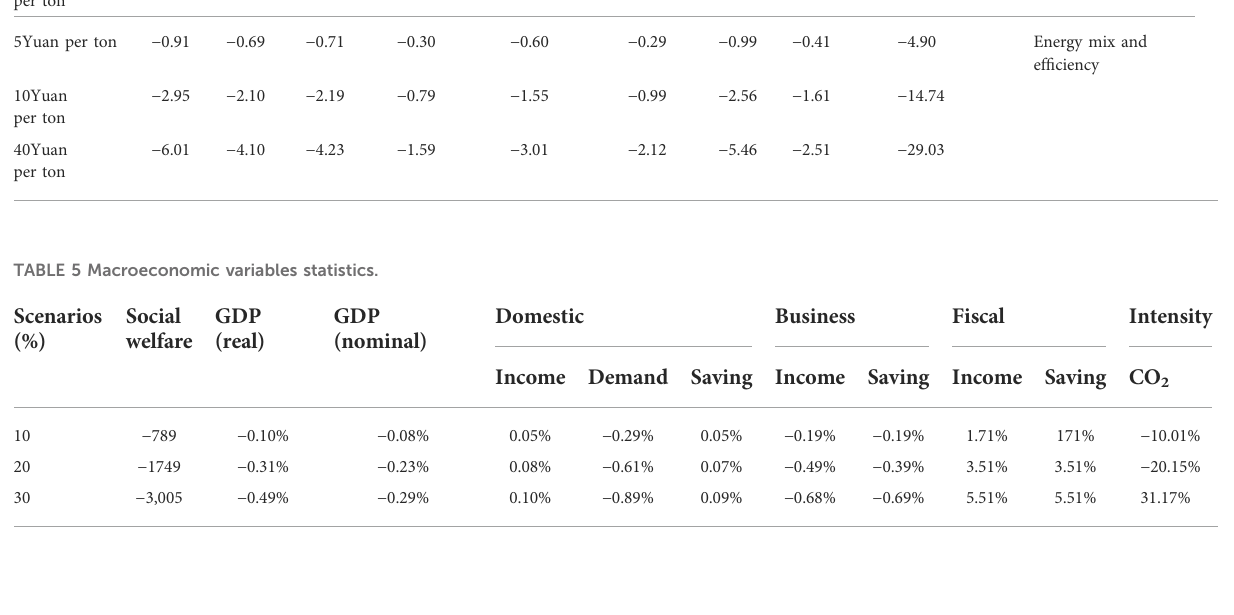
TABLE 6 Macroeconomic effects of the different carbon